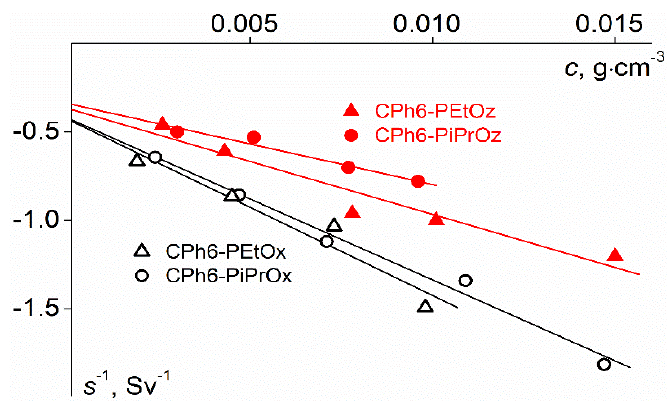
Figure 1. Concentration dependences of the inverse sedimentation coefficient 1/ s for the studied polymer stars in chloroform. Table 1. Hydrodynamic characteristics and molar masses of investigated polymer stars.